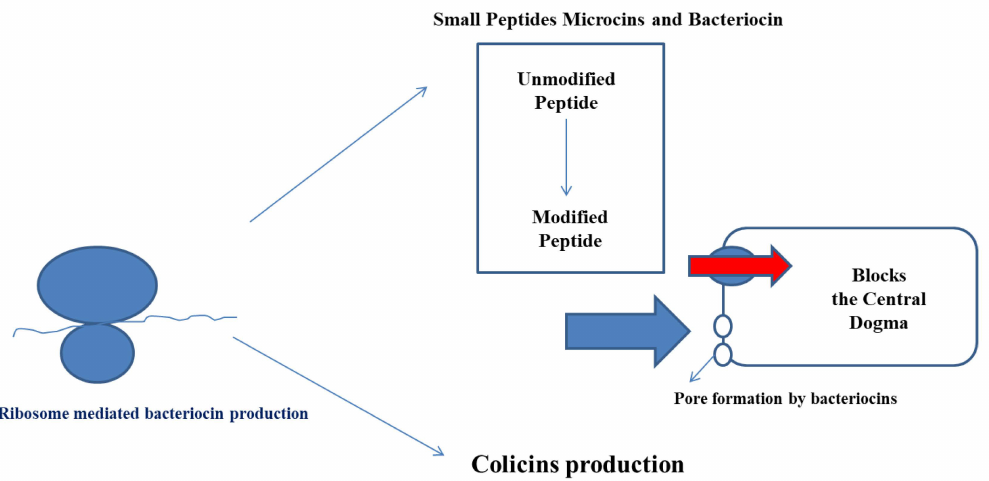
Figure 2. Mode of action of the bacteriocins in preventing the growth of other microbial